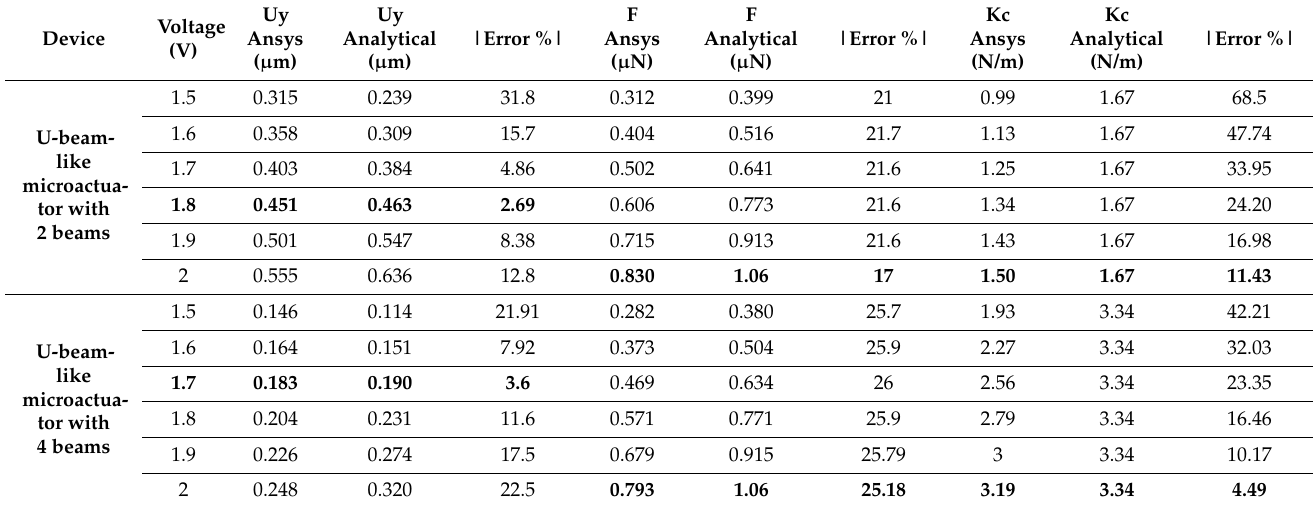
Table 5. Parameters results for microactuators.